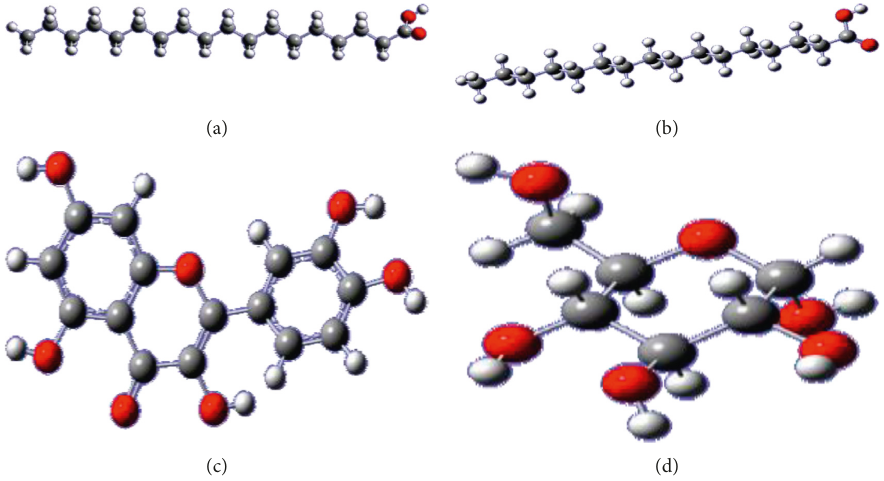
Figure 2: Biological molecules used in this study: (a) stearic acid, (b) palmitic acid, (c) quercetin, and (d) glucose.